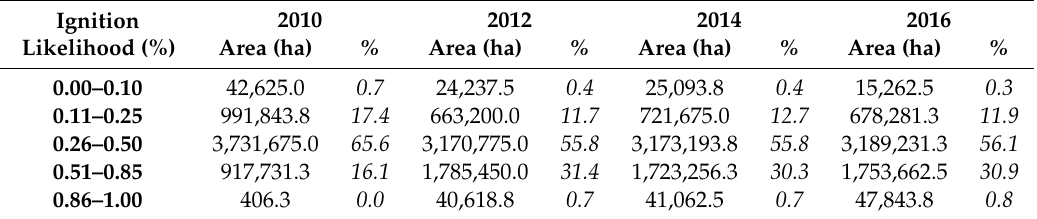
Table 2. Predicted fire ignition probability classes over the studied